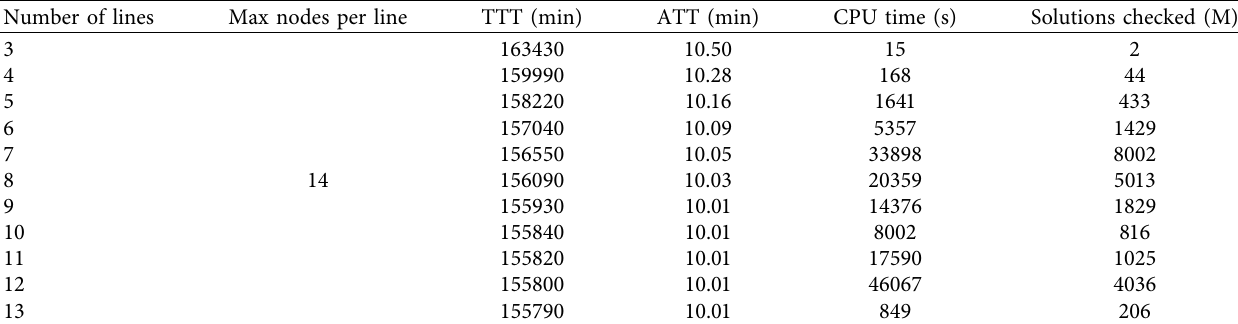
Table 3: Optimal solutions for Mandl’s Swiss network with no limitations to route